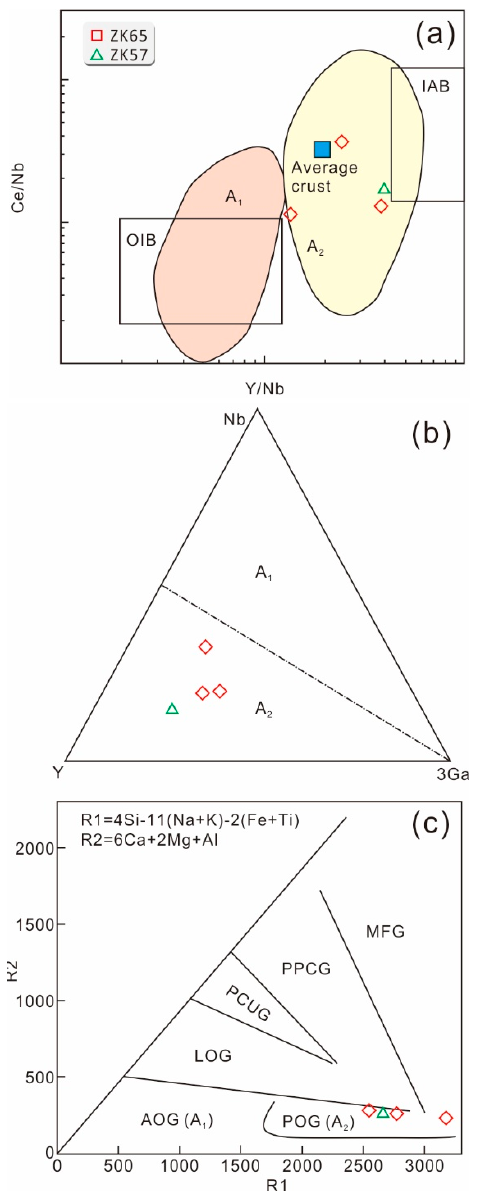
Figure 11. ( a ) Plots of Ce/Nb vs. Y/Nb [70]; ( b ) Nb-Y-3Ga [70]; ( c ) the diagrams of Ta-Yb, “R1-R2” [69] for the Xianghualing granites. OIB, ocean island basalt; IAB, island arc basalt; MFG, mantle-fractionated granite; PPG, pre-plate collision granitoids; PUCG, post-collision uplift granitoids; LOG, late-orogenic granitoids; AOG, anorogenic granitoids; POG, post-collision granitoids.